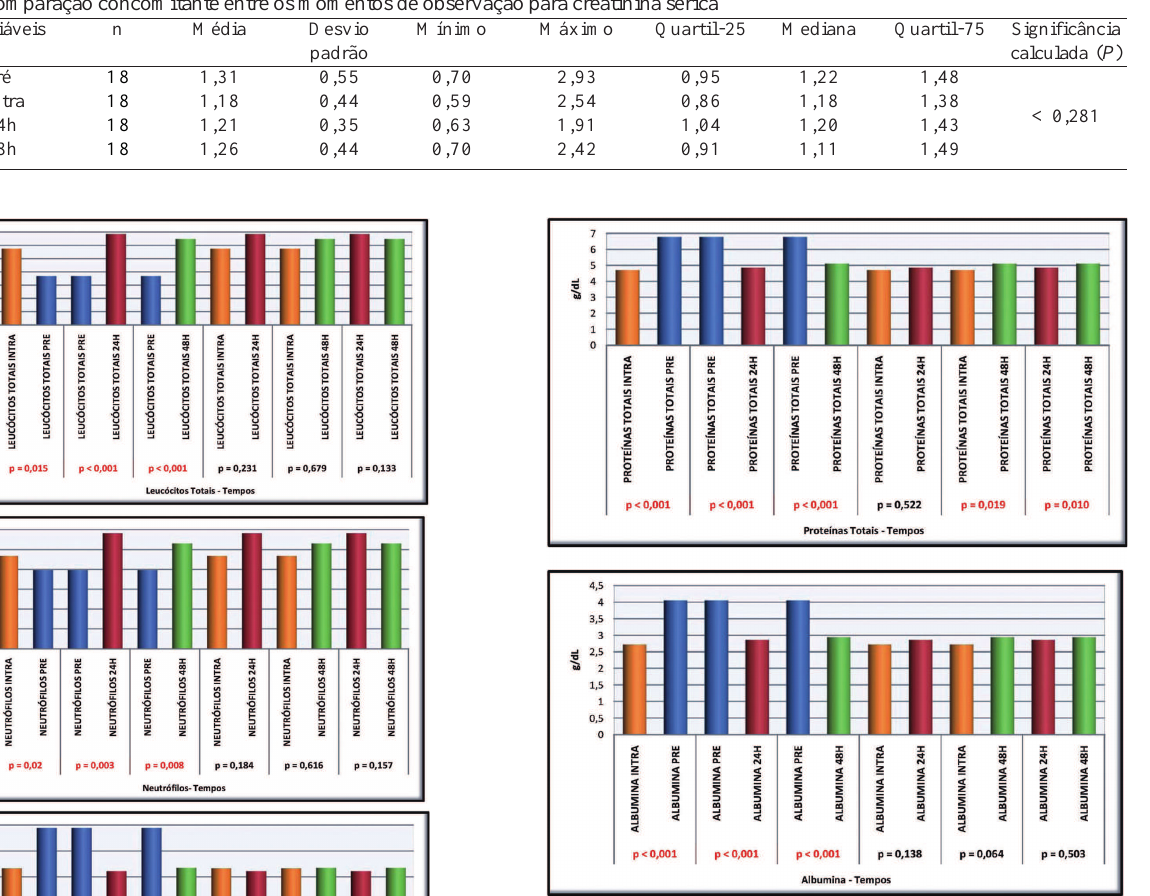
Fig. 2 – Comparação concomitante entre os momentos de observação para proteínas totais e albumina